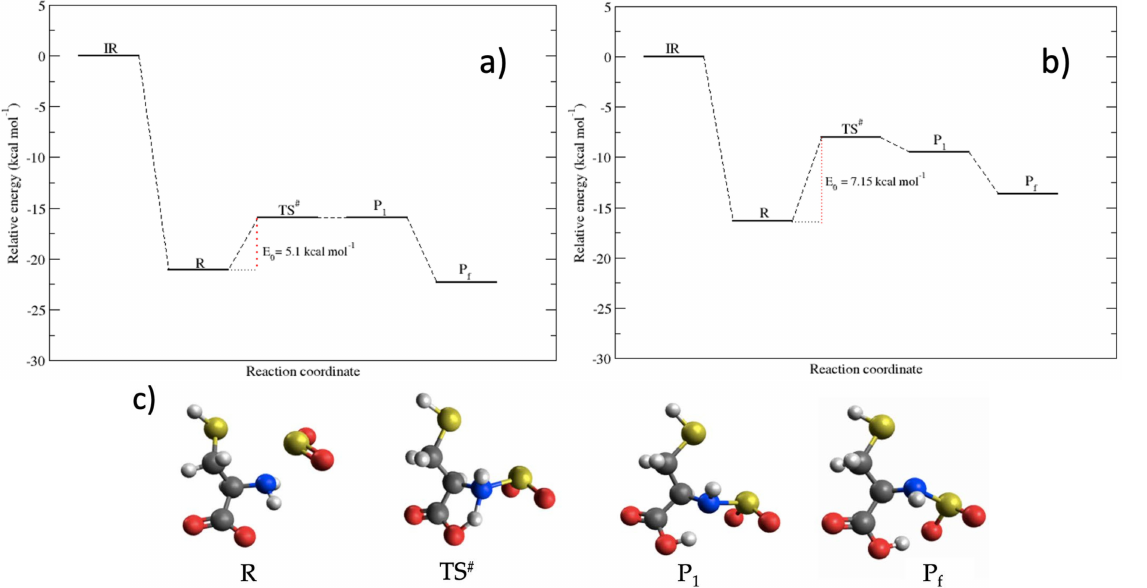
Figure 6. Reaction energies of the Cys-TS5 path with respect to isolated reactants as computed using ZPE corrected electronic energies. ( a ): Reaction in the gas phase. ( b ): Reaction in the SMD solvent model. ( c ): Optimized geometries in the gas phase of the stationary points along the reaction